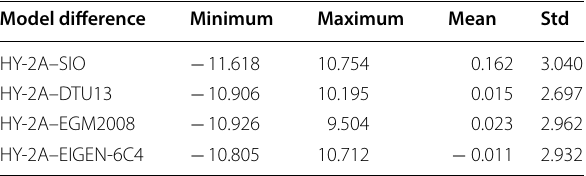
Table 7 Comparing new version of HY-2A-derived gravity anomalies with other models (unit: mGal)